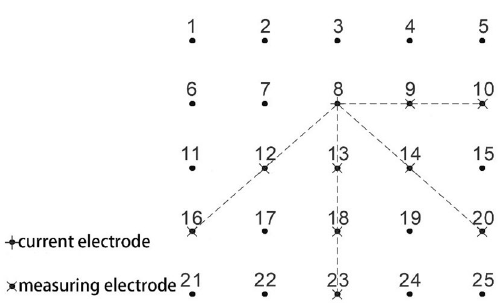
Figure 4. Schematic diagram of cross-diagonal measurement